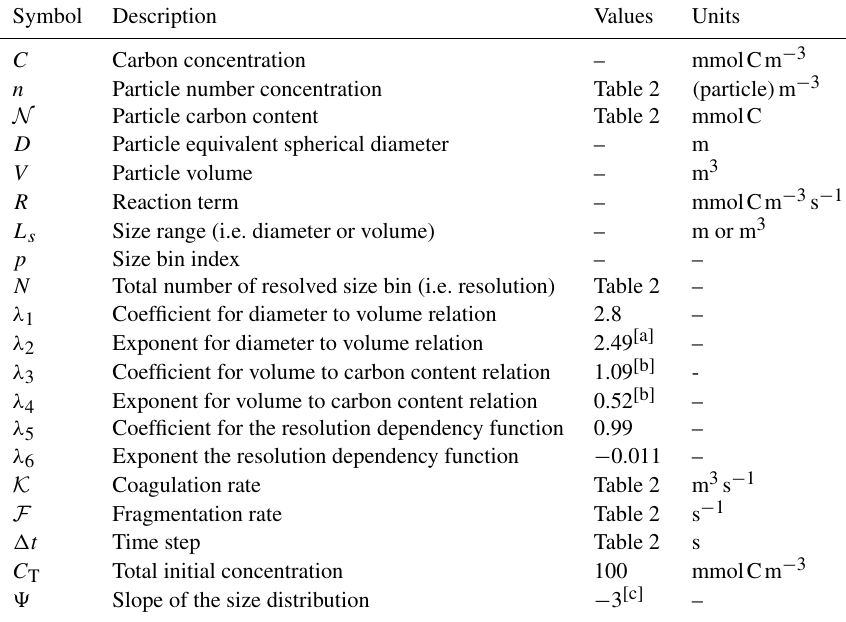
Table 1. Model variables and